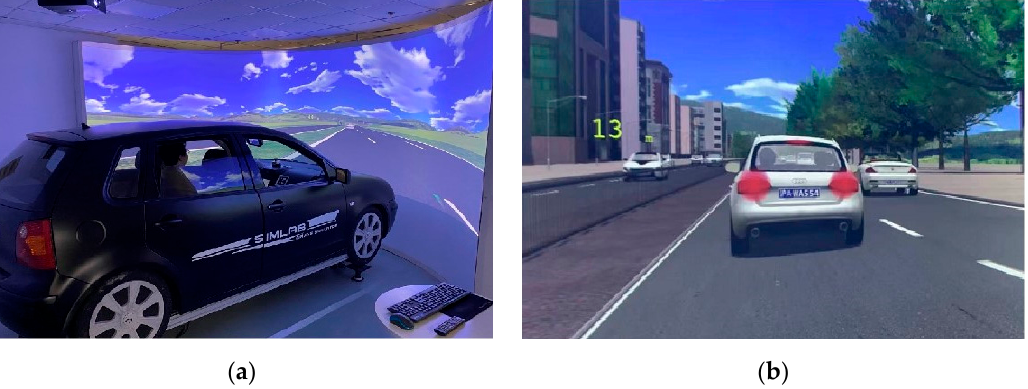
Figure 1. ( a ) The SILAB driving simulator and ( b ) the simulated ordinary road driving environ ‐ ment.